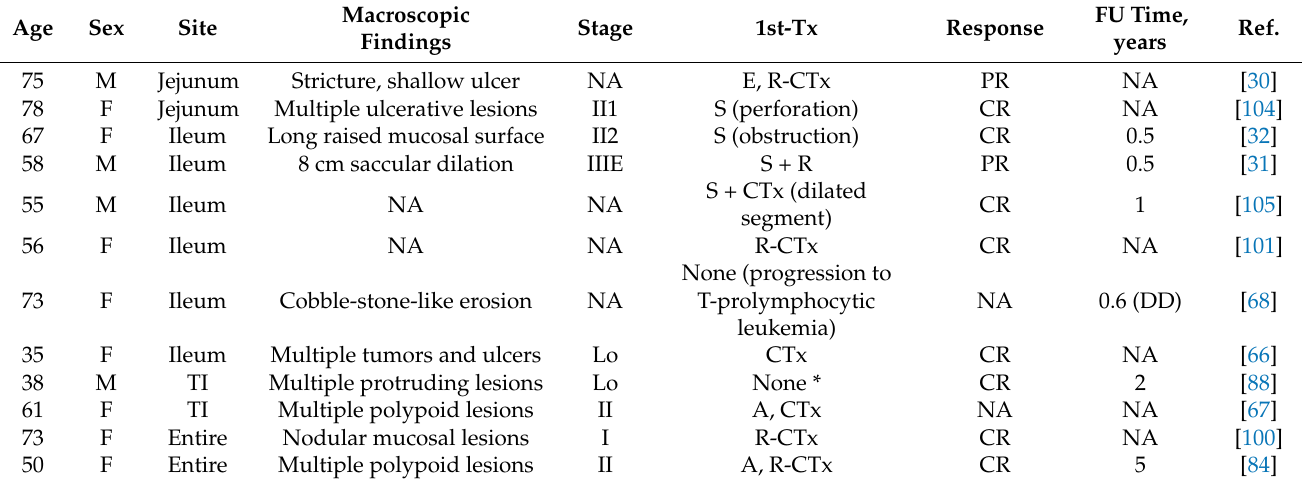
Table 3. Summary of recently reported cases of small intestinal MALT lymphoma.